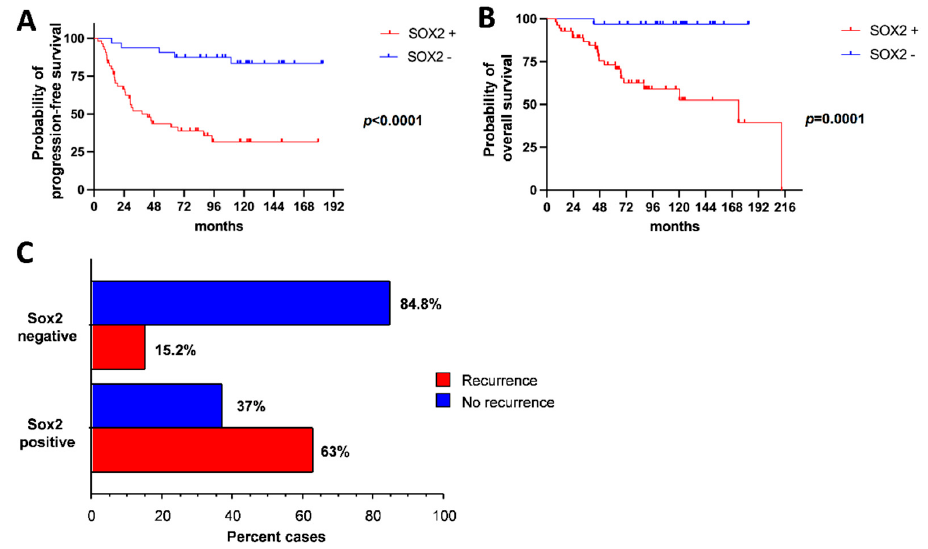
Figure 4. ( A , B ) Kaplan–Meier survival curves for PFS ( A ) and OS ( B ) in the whole series. ( C ) Probability of tumor recurrence depending on SOX2 IHC status.